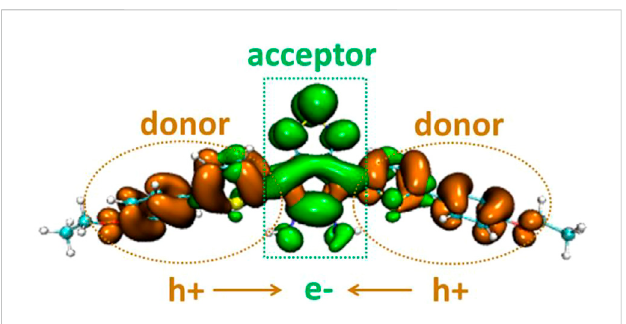
FIGURE 5 Electron distribution difference between S 0 and S 1 of DAD-NO (orange andgreenintheisosurfacemaprepresenttheholeandelectron distribution in the excitation process).